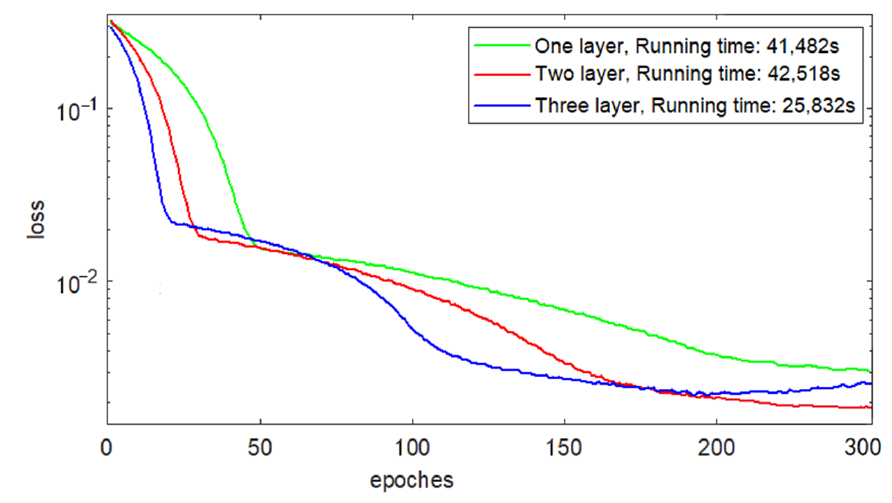
Figure 5. Loss function of network training process.